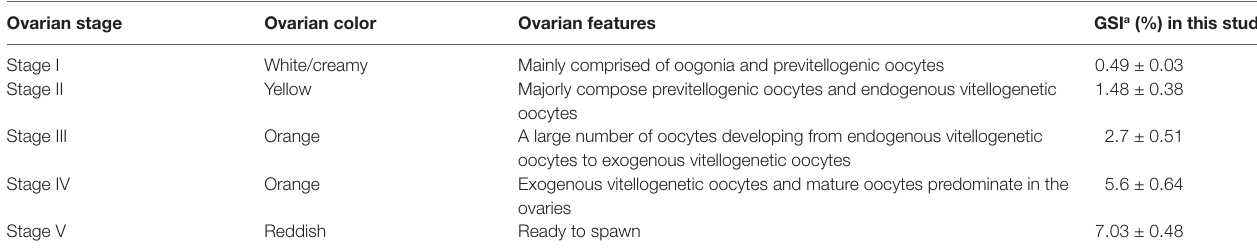
TABLE 1 | GIS of M. rosenbergii at different ovarian development stages (stages